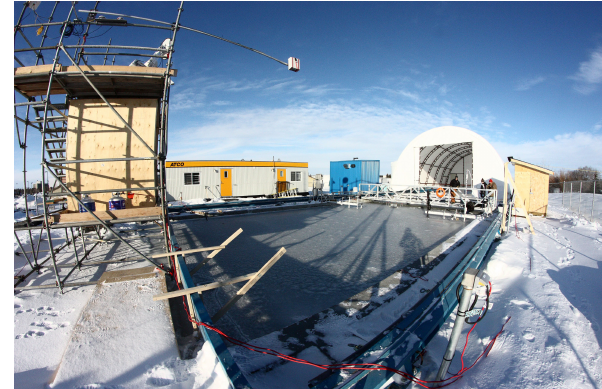
Figure 1. The Sea-ice Environmental Research Facility (University of Manitoba, Winnipeg, Canada) with thin sea ice covering the pond during the 2013 experiment. Photo: J.